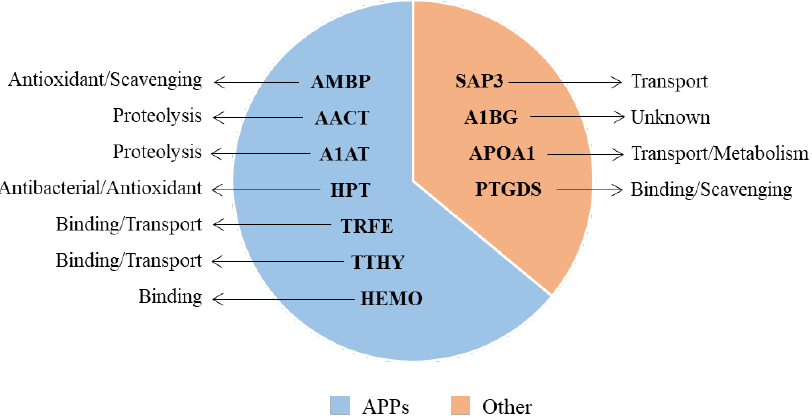
Figure 3. Principal roles of the differentially expressed proteins. The majority (64%) were acute-phase response proteins (APPs) involved in various biological processes, while the others (36%) were proteins with similar or different molecular functions.